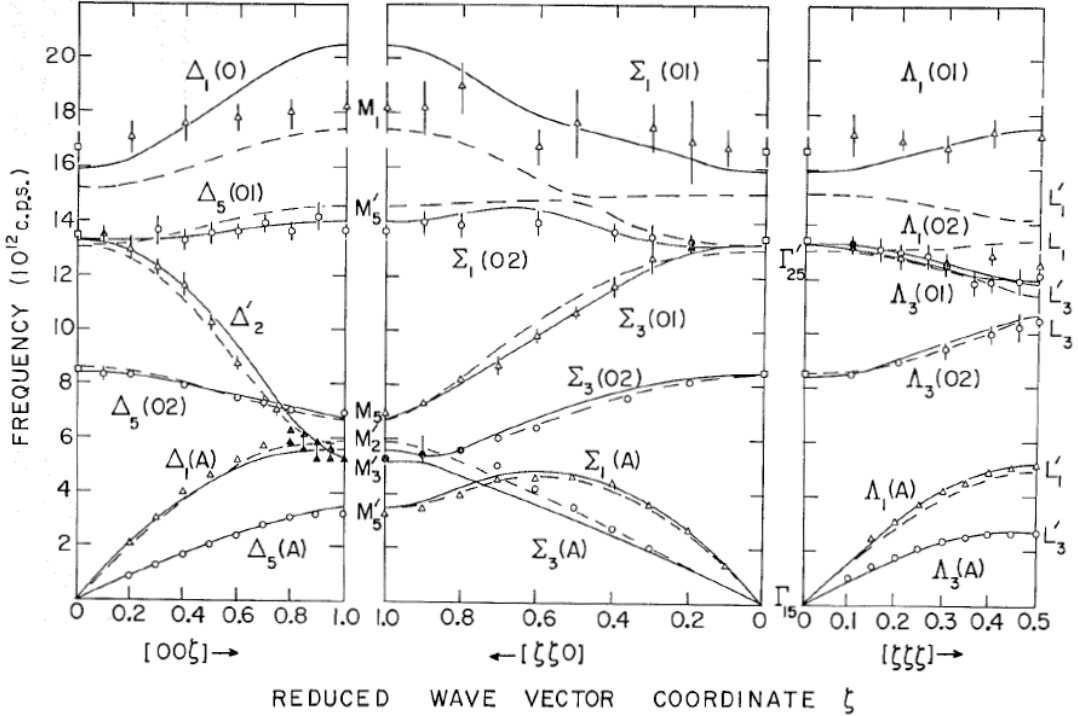
Figure 35. The phonon dispersion relations for UO 2 at 296K in three directions of high symmetry. The dashed (solid) curves show the best least squares fit to a rigid ion (shell mode). In the Δ and Λ directions, the open circles (triangles) denote transverse (longitudinal) modes. Solid points denote modes of uncertain polarization. This figure is taken from Figure 4 of ref. [58] and is reproduced courtesy of Canadian Science Publishing and its licensors.